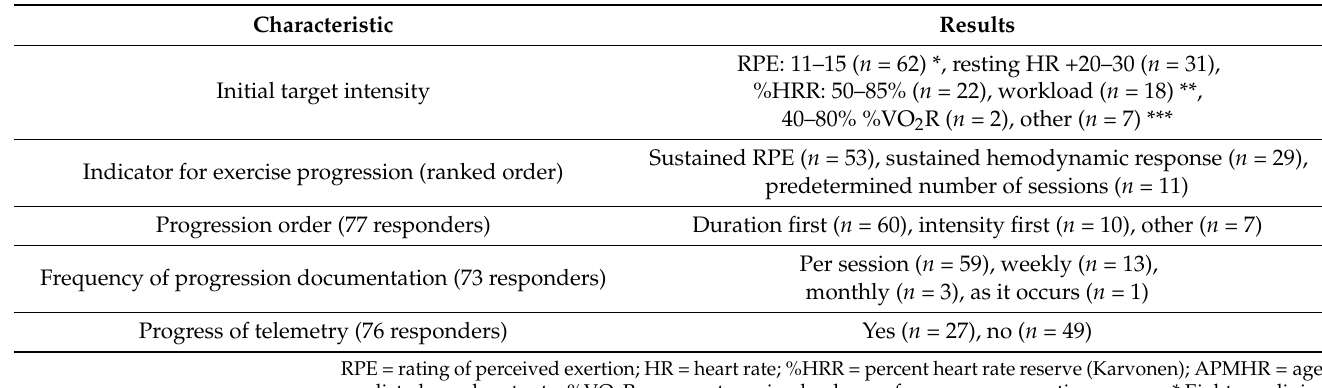
Table 2. Initial exercise intensity and exercise progression